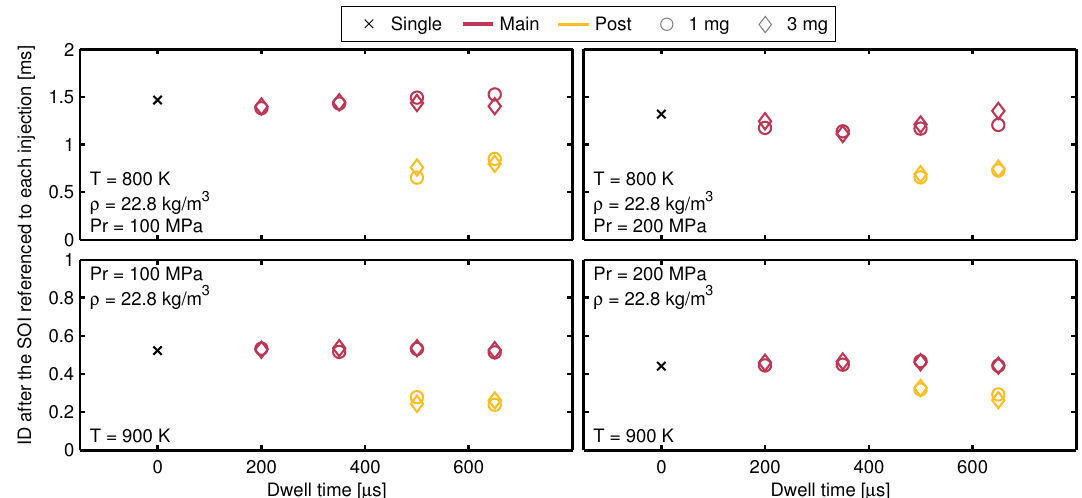
Figure 10. Ignition delay results for main-post strategies and all conditions tested. Values are referenced to the start of injection of each